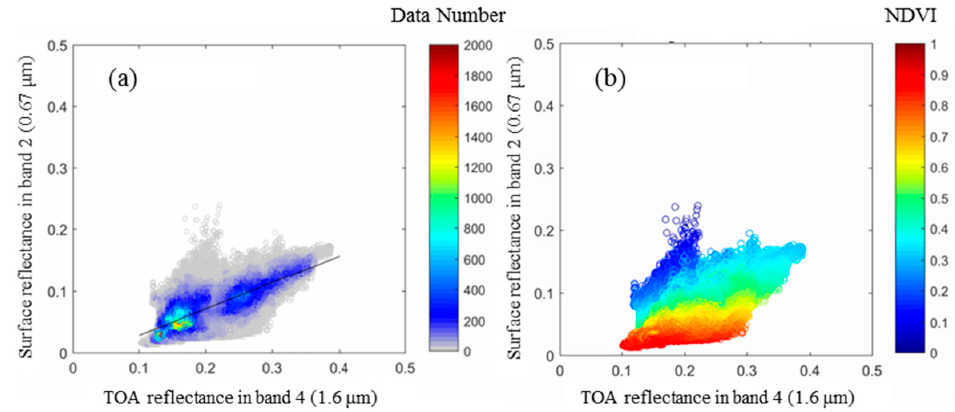
Figure 2. Scatter plots of top-of-atmosphere (TOA) reflectance at 1.6 μ m and surface reflectance at 0.67 μ m with: density data frequency ( a ); and NDVI ( b ). The results are from TANSO-CAI/AERONET collocated data (selected from the s marked AERONET sites in Table 1) in 2011 with AOD (at 0.55 μ m) < 0.1.